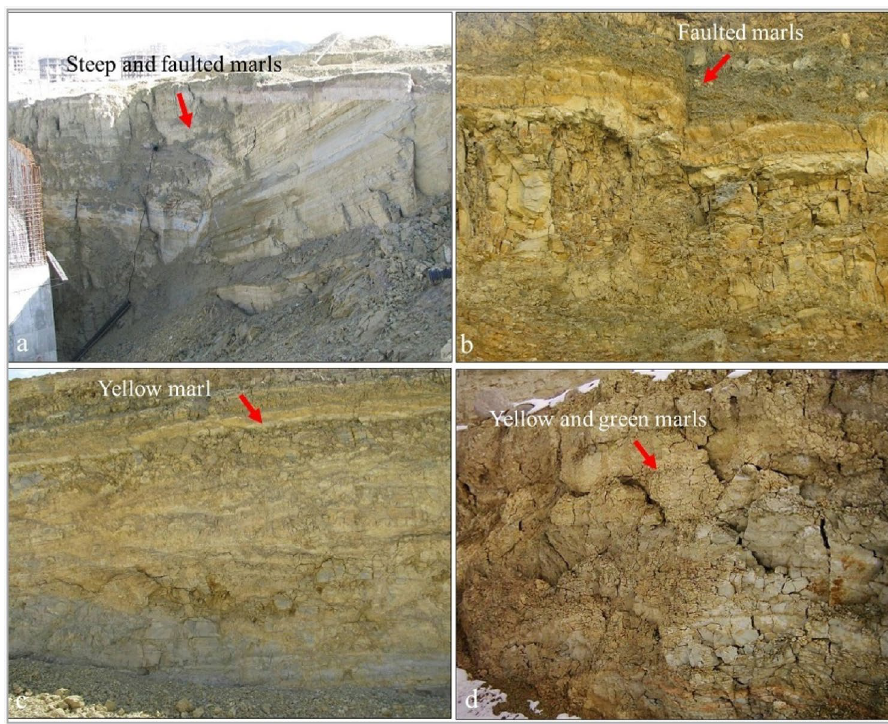
Fig. 5 Images of steep and faulted marls near L2E10 borehole in Baghmisheh town ( a ), Faulted marls near L2E13 borehole in Marzdaran area ( b ), Yellow marl around of L2E12 borehole in Barenj area ( c ) and Yellow and green marls in around of Baghmisheh Town ( d )